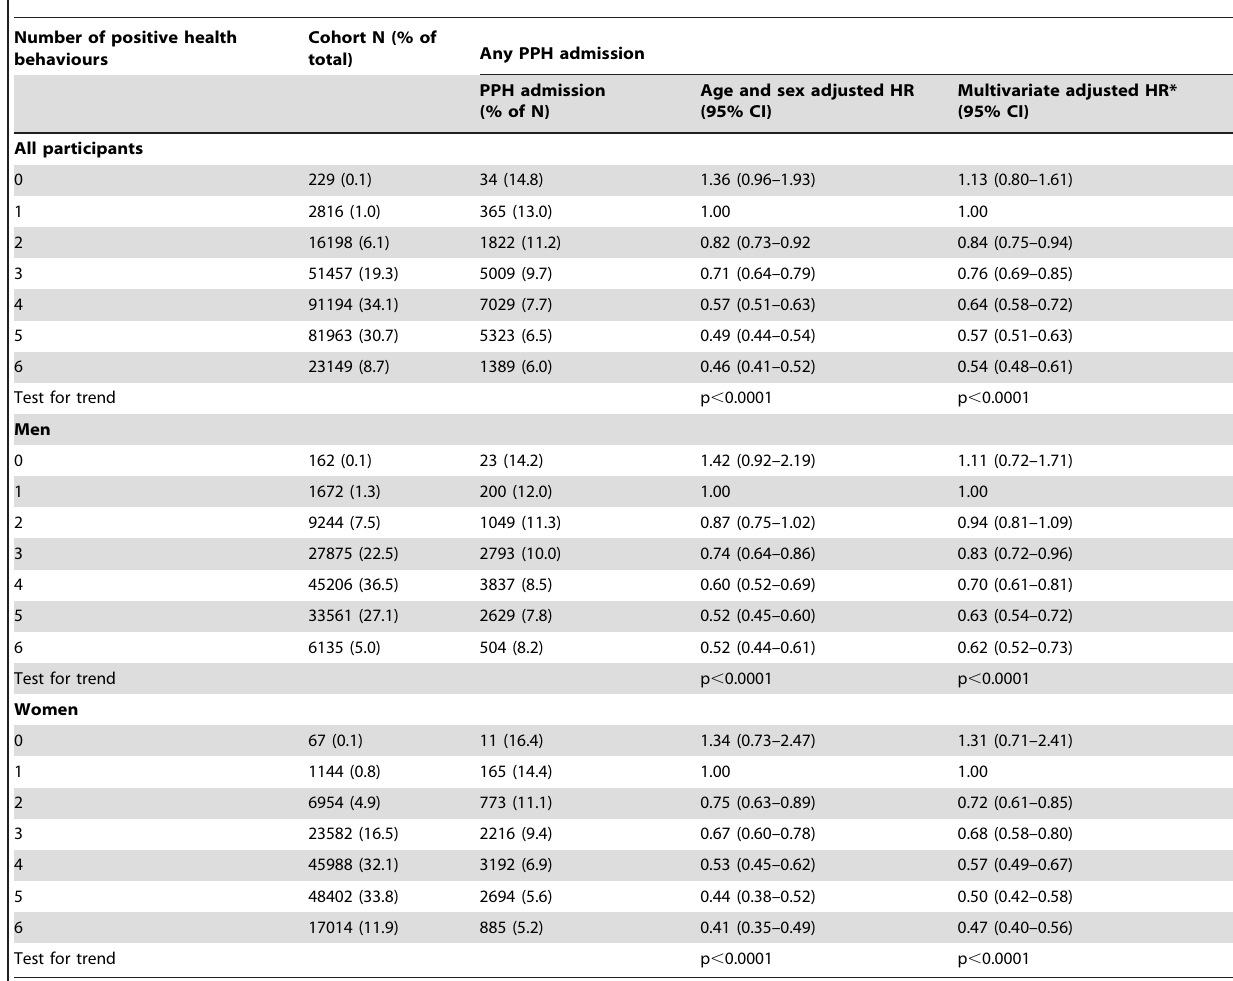
Table 3. Risk of potentially preventable hospitalisation (PPH) by number of positive health behaviours.